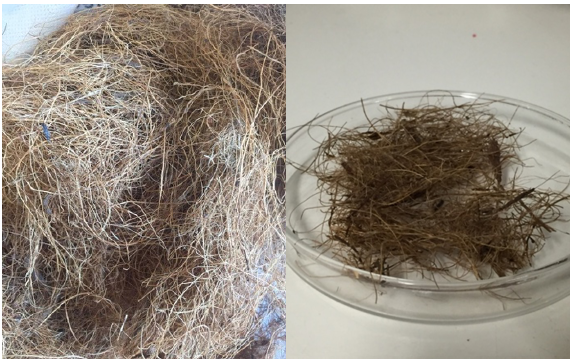
Figure 2. Coir fibers used in this work.